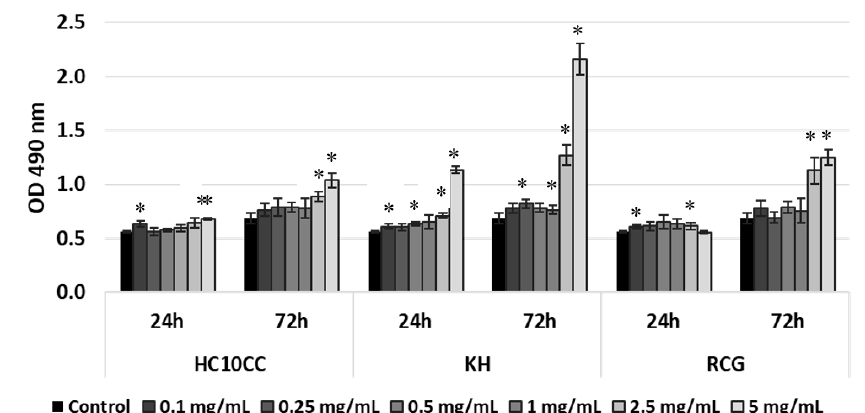
Figure 7. Evaluation of LDH activity released into the culture medium by the L929 cells grown in the presence of HC10CC, KH, and RCG electrospun nanofibers at 24 and 72h post-seeding. Data are expressed as mean value ± SD (n = 3). * p < 0.05, compared to the untreated cells (control).